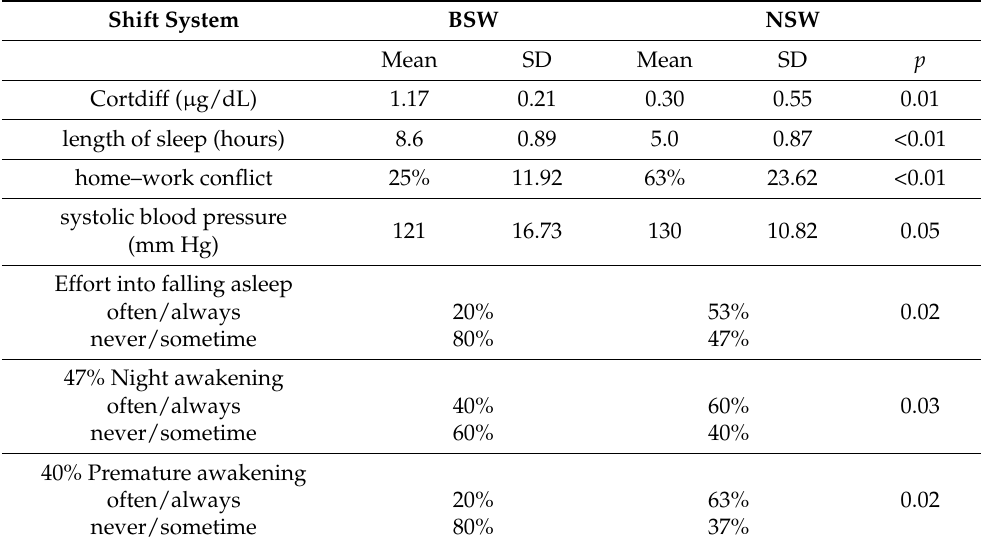
Table 6. Association of the shift system with perceived stress and biological and clinical